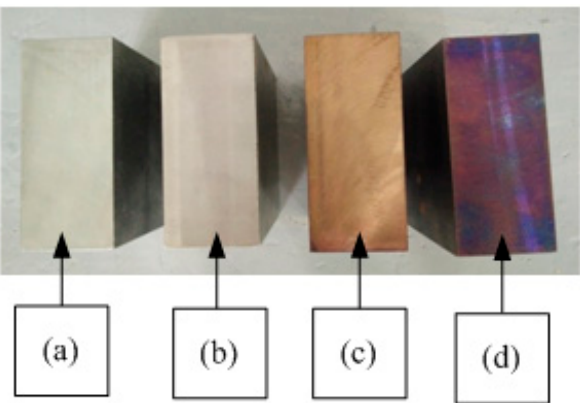
Figure 3. The relationship between generated temperatures and heating times by using induction coil of SKD11 tool steel.